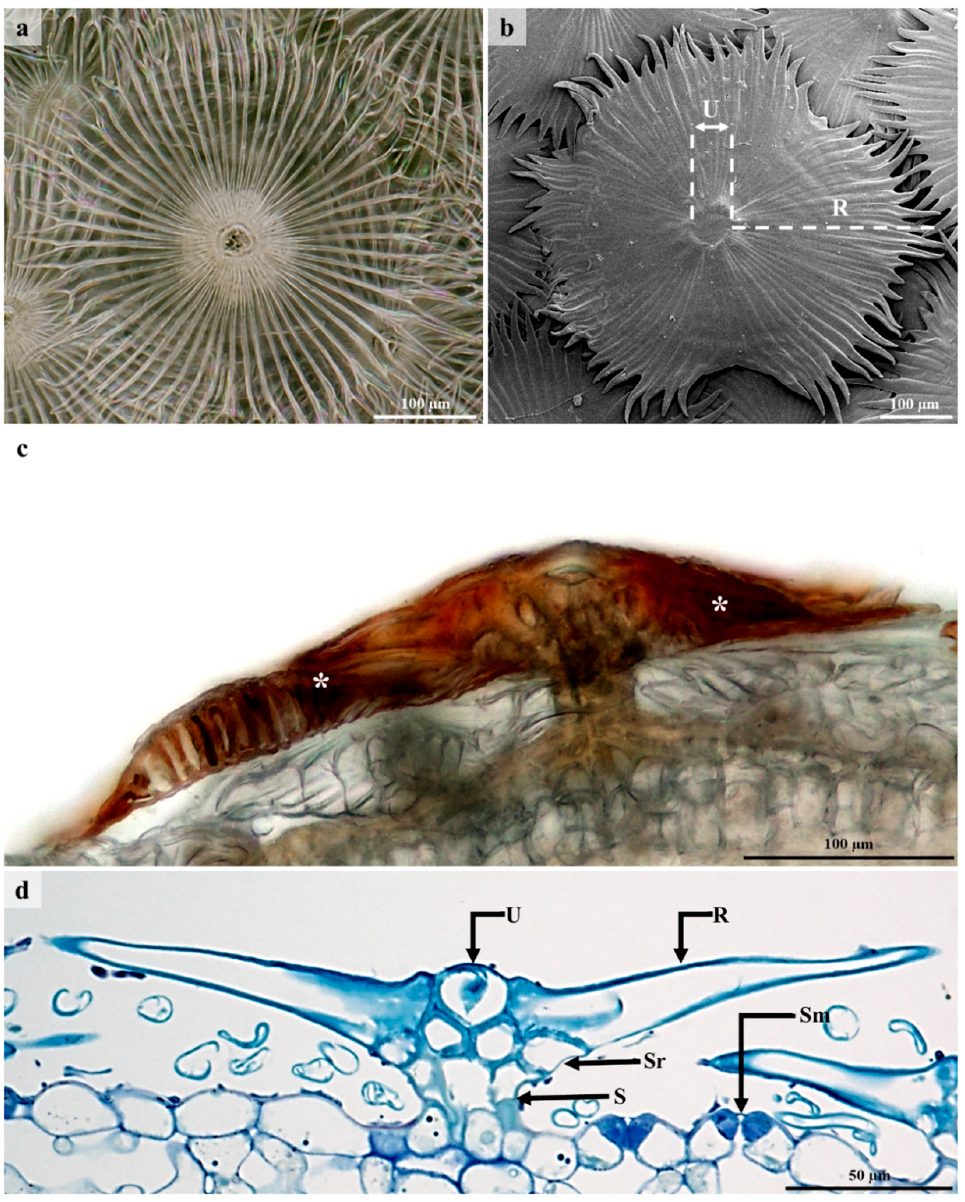
Figure 3. Morphology of lepidote trichomes. ( a ) Stereomicrograph of lepidote trichome. ( b ) SEM of lepidote trichome showing umbo/central cell and numerous webbed radial cells. ( c ) Lepidote trichome with dark brown accumulated secretory substance. ( d ) Light micrograph of lepidote trichome showing stalk cells, subradial cells, radial cells, and umbo/central cell. U—Umbo, R— Radii/Radial cell, Sr—Subradial cell, S—Stalk,